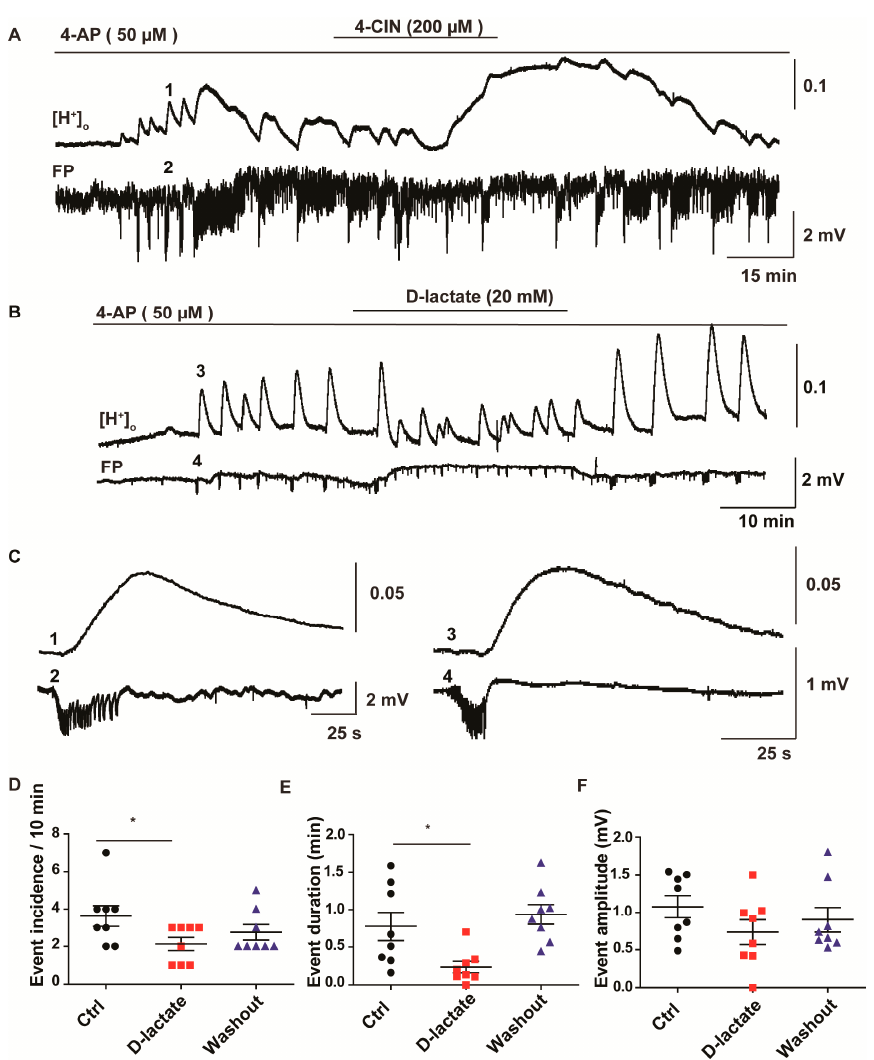
Figure 4. Effect of MCT inhibitors—4-CIN and D-lactate—on baseline and SLE-associated changes in extracellular pH. Extracellular H + ion concentration was measured using ion sensitive electrodes; hence the displayed traces show change in H + ion concentration which got converted to pH units. ( A ) Application of 4-CIN resulted in a late onset baseline acidotic shift; ( B ) In contrast, application of sodium D -lactate (20 mM, osmolality and pH set as in normal aCSF) did not induce changes in baseline pH while exerting similar inhibitory effects on 4-AP induced epileptic form activity; ( C ) Sample trace of single SLE with corresponding pH change in different time scale. Each individual SLE was associated with small acidotic shifts in both 4-CIN (1,2) and D -lactate (3,4) experiments, traces taken from the recordings in ( A , B ) as shown by the corresponding number; ( D ) SLE incidence and ( E ) duration ( F ) but not the amplitude were significantly decreased; ( D – F ) Variables are given on the Y -axis, categories of treatment on the X -axis. * p < 0.05. Each dot represents a single data point, black dots represent 50 µM 4-aminopyridine (4-AP) application, red dots represent 20 mM D -lactate and 50 µM 4-AP application, blue dots represent washout in 50 µM 4-AP.